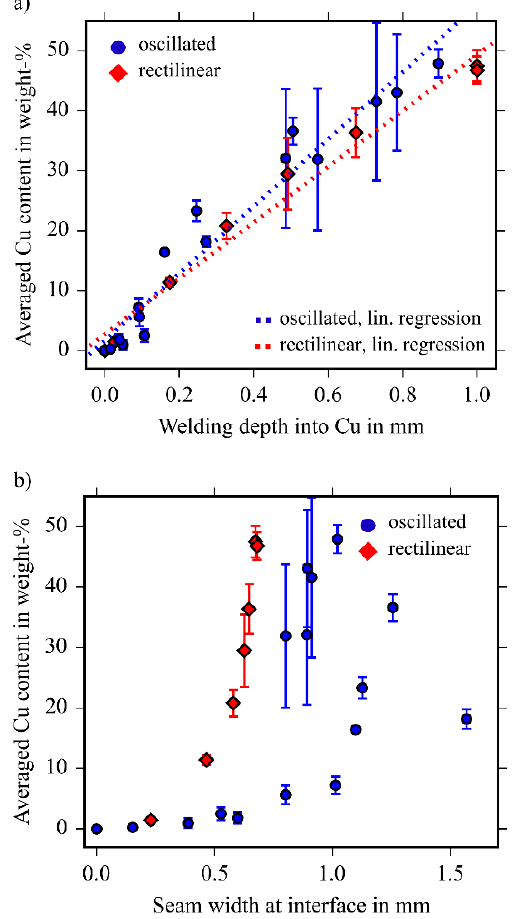
Figure 12. ( a ) Averaged Cu content in the weld seam in dependence on the welding depth. The markers indicate the measured values; the dotted lines represent a linear regression of the averaged Cu content on the welding depth; ( b ) averaged Cu content in the weld seam in dependence on the width of the seam. The error bars indicate the standard deviation.